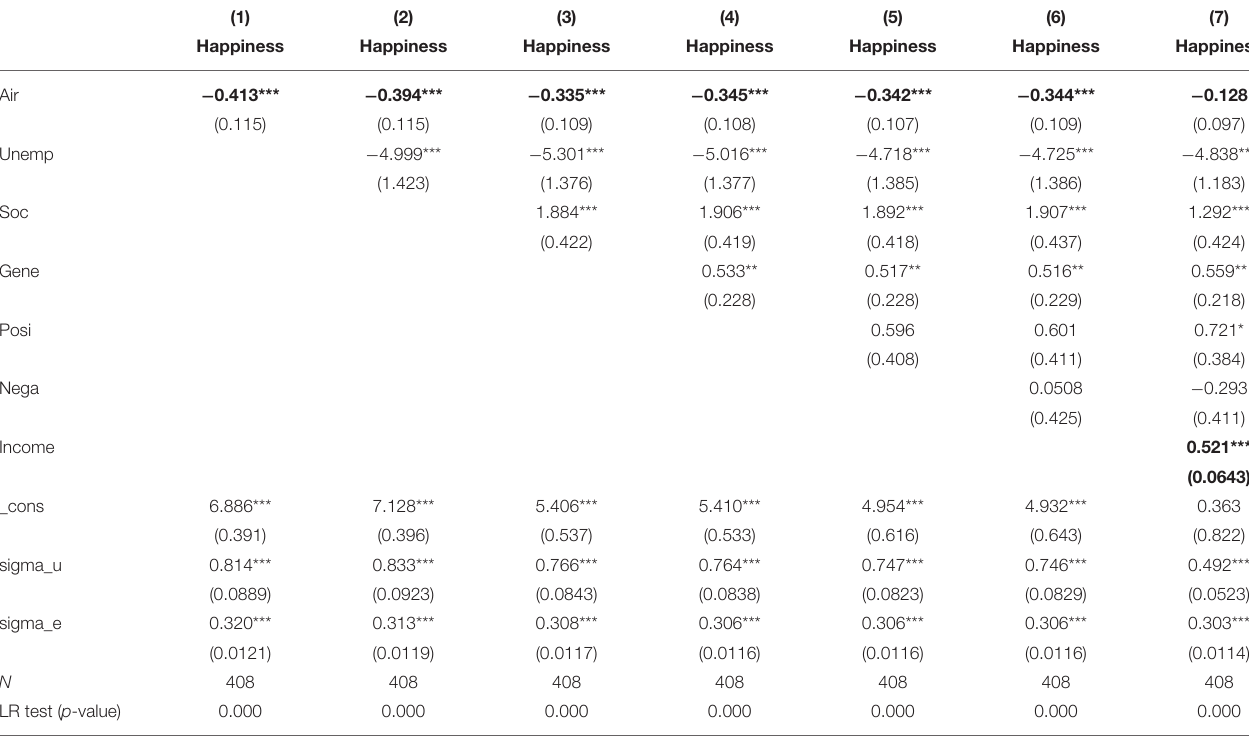
TABLE 4 | Regression results of air pollution on happiness under complete